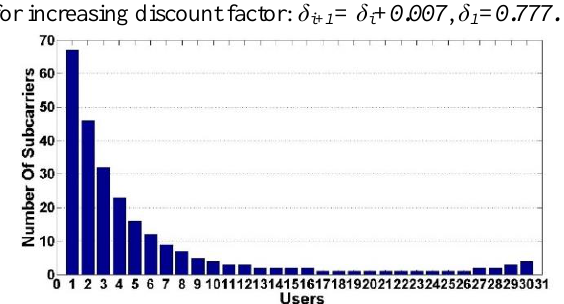
Fig. 5. Subcarriers allocation for increasing discount factor: δ i+1 = δ i +0.007 , δ 1 =0.700.